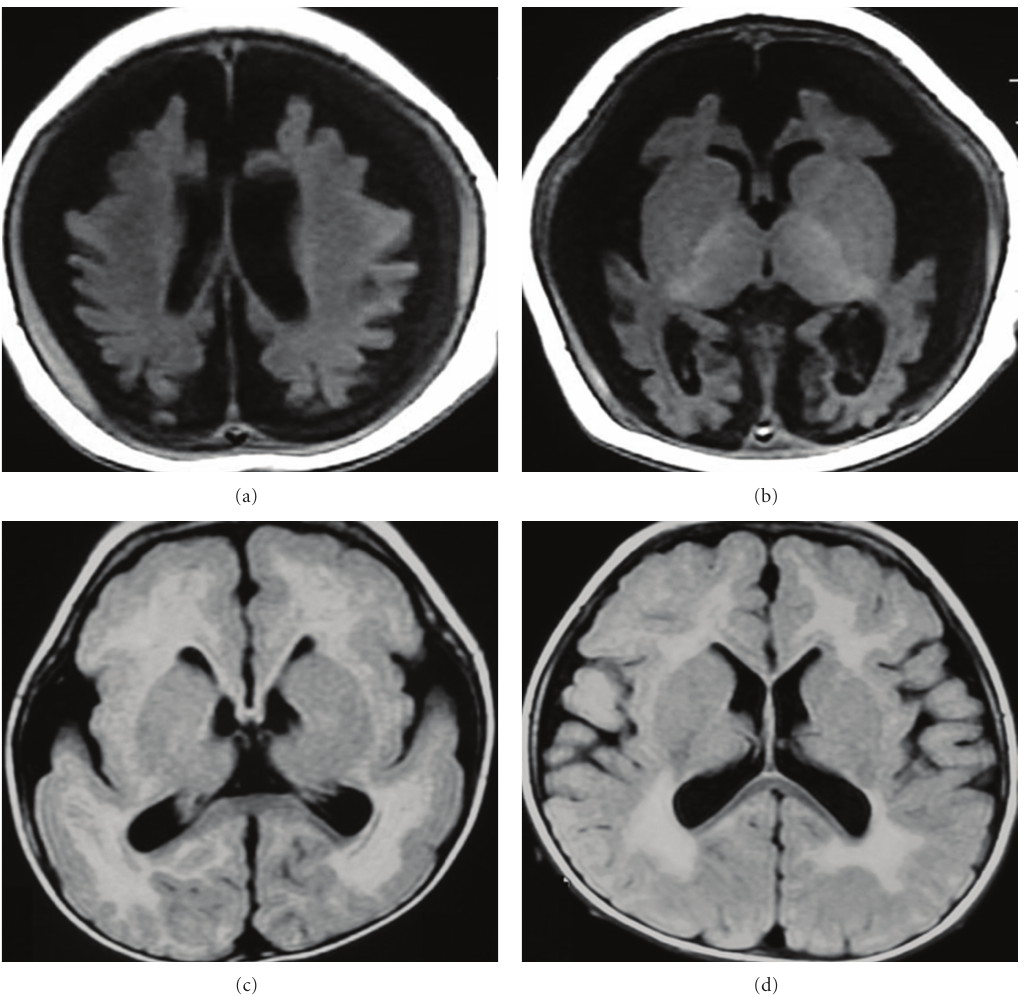
Figure 4: Representative MRI findings in di ff erent malformations of cortical development (MCD). Figures 4(a) and 4(b) showed severe cortex dysplasia in bilateral parietal lobes and frontal, temporal and occipital lobes, respectively, in the telencephalon of a 5-month-old male with NDD. Figure 4(c) demonstrated typical lissencephaly in a 9-month-old female with Miller-Dieker syndrome. The white matter volume was decreased while the cortex was thick and smooth due to lack of enough sulcation, forming the so-called pachygyria malformation, and the thickened and irregular cortex in Figure 4(d) revealed the cobblestone cortical malformation in a patient with muscle-eye-brain